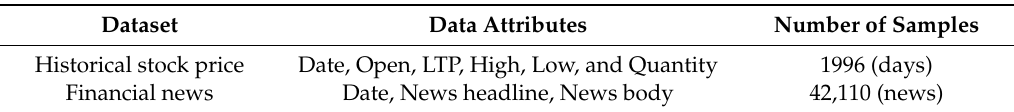
Table 1. Description of datasets.